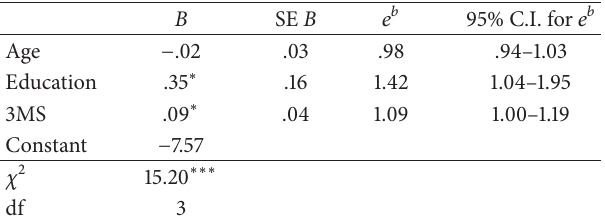
Table 6: Logistic regression analysis predicting e-mail use from age, education, and cognitive function